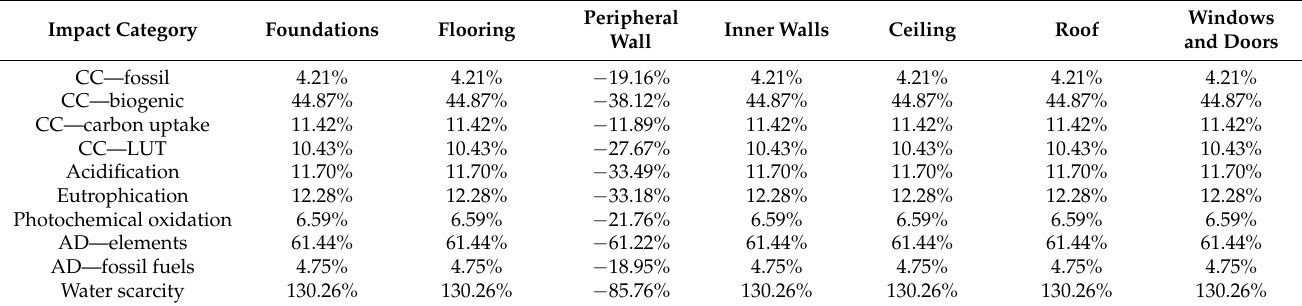
Table 5. Stone wool insulation instead of LDF—sensitivity analysis